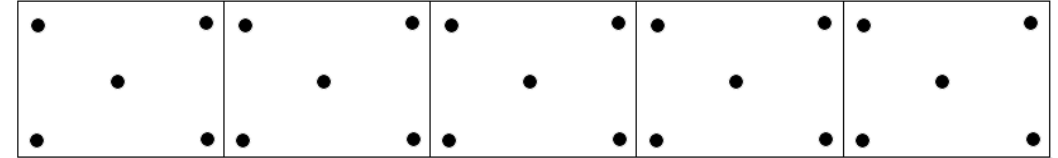
Figure 1. Example of stimuli from the five-point test. The complete test consists of 40 five-point rectangles arranged in 8 rows of 5 rectangles on an 8 ½ × 11 inches sheet.